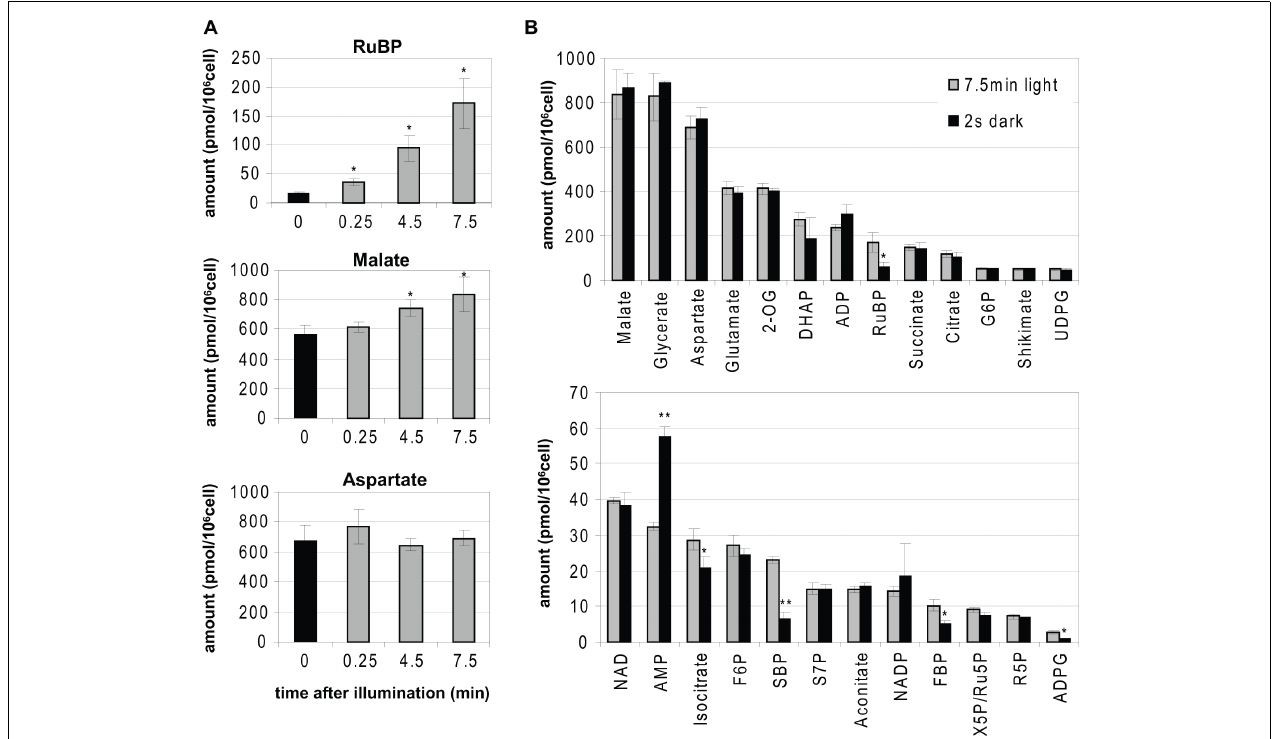
FIGURE 1 | Example of rapid metabolic response by light and darkness. Metabolites in Chlamydomonas reinhardtii CC-1690 were measured after quenching in an excess of cold ( − 70˚C) methanol, lyophilization, and extraction in chloroform-methanol using IPC–MS/MS. (A) Ribulose-1,5-bisphosphate (RuBP), malate, and aspartate levels in Chlamydomonas CC-1690 cells are shown after dark-adaption for 20min (black bars) and exposure to 660 μ mol photon m − 2 s − 1 for 0.25, 4.5, and 7.5min (gray bars). Y -axis indicates amount (pmol/10 6 cell). (B) Chlamydomonas cells were harvested in cuvettes after 20min dark-adaption and exposure to 660 μ mol photon m − 2 s − 1 for 7.5min without (gray bars) or